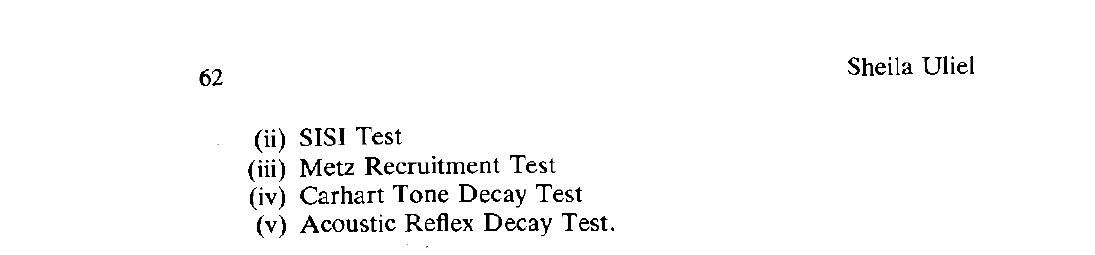
TABLE 1: Summary of the Criteria for Subject Selection, Differentiating them into EG and